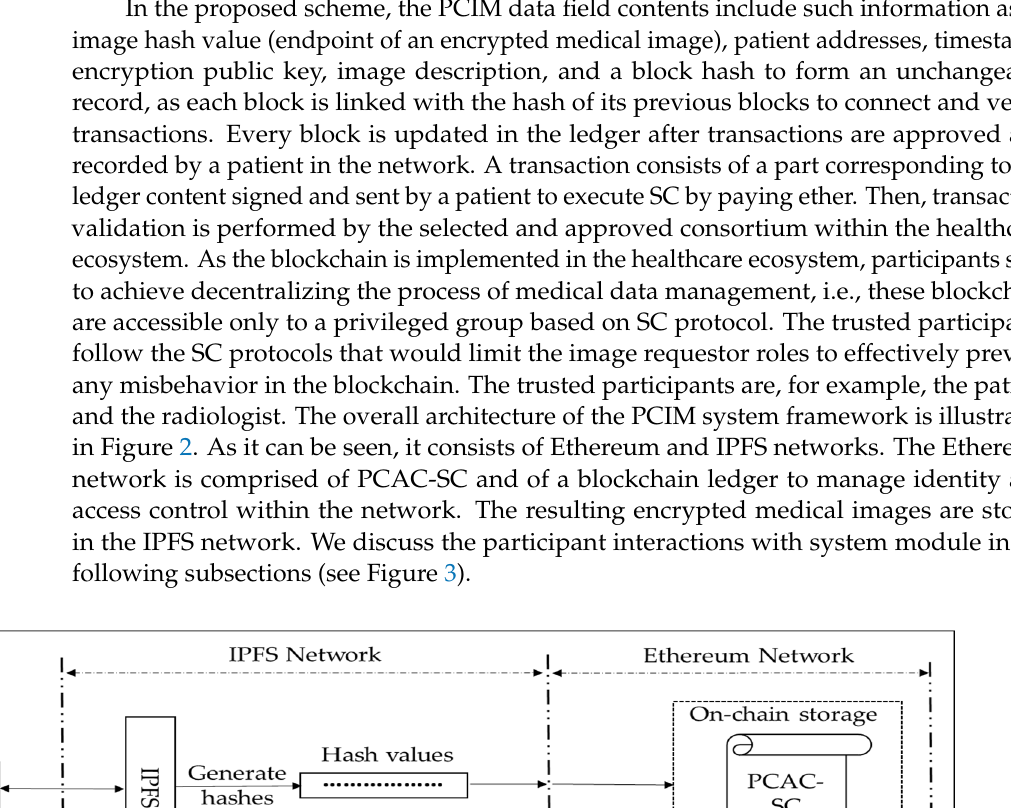
Figure 1. Blockchain ledger data structure.